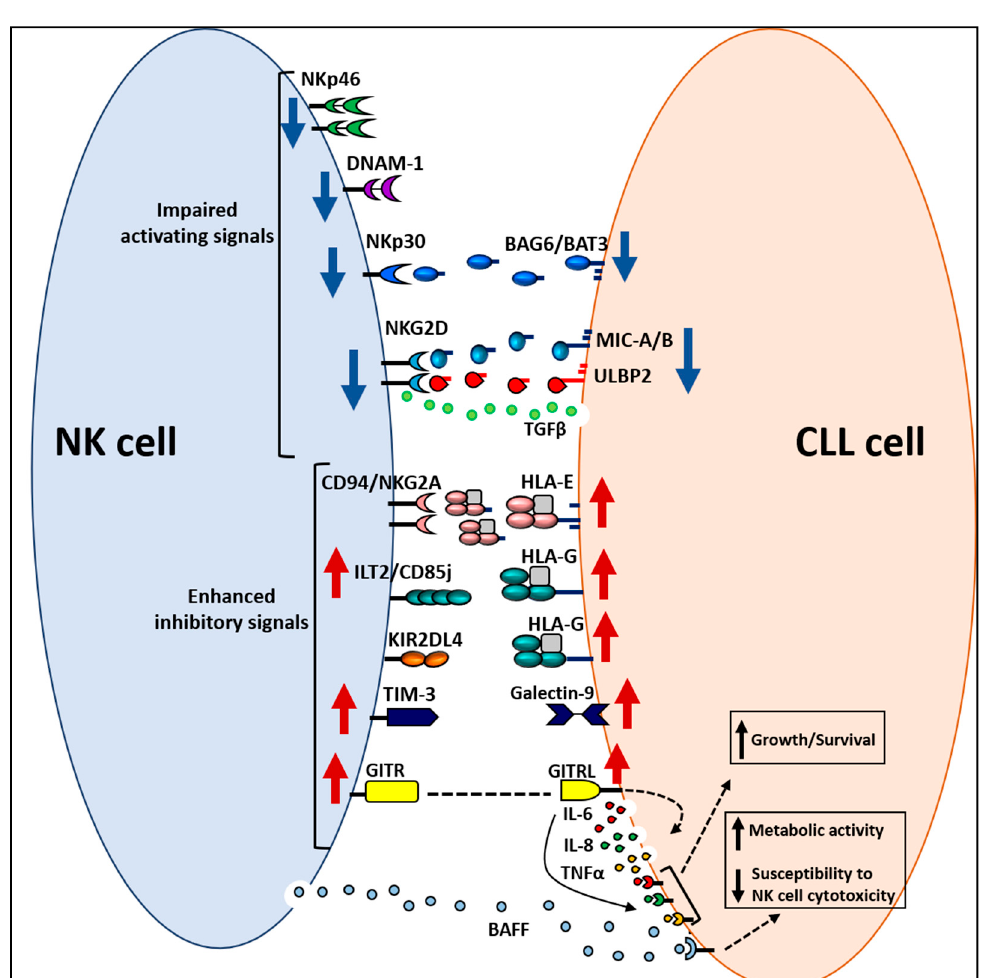
Figure 2. A hypothetical model of chronic lymphocytic leukemia (CLL) escape from natural killer (NK) cell immune surveillance. The escape of CLL cells from the NK cell response relies on multiple mechanisms: (i) reduced expression of activating receptors on NK cells or their ligands on CLL cells; (ii) release by CLL cells of soluble ligands for NK cell activating receptors; (iii) increased expression of inhibitory receptors on NK cell surface and of their ligands on CLL cells; (iv) NK cell-induced signals that increase CLL cell growth/survival and metabolic activity and impair CLL cell susceptibility to NK cell-mediated cytotoxicity. The red and blue arrows indicate increased and decreased cell surface expression, respectively, of NK cell receptors or their ligands on CLL cells. Dotted line indicates GITR–GITRL interaction. Dotted arrows indicate intracellular signaling.